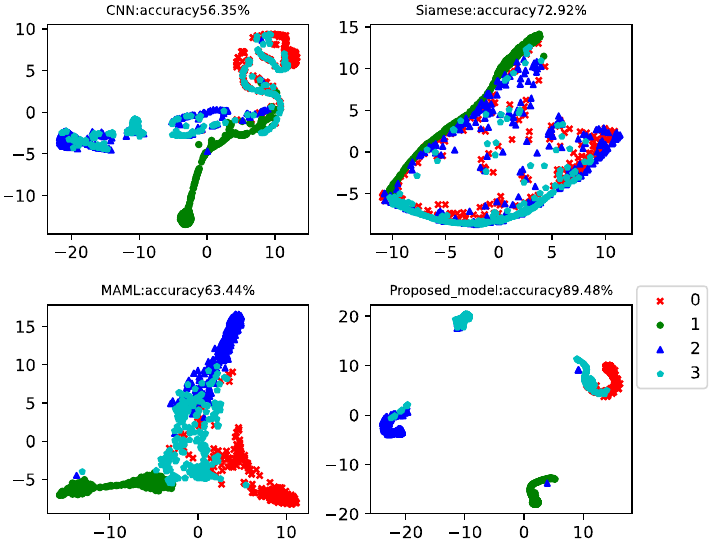
Figure 8. Four-way-one-shot diagnosis of the generator bearing data for the wind turbines using different algorithms.